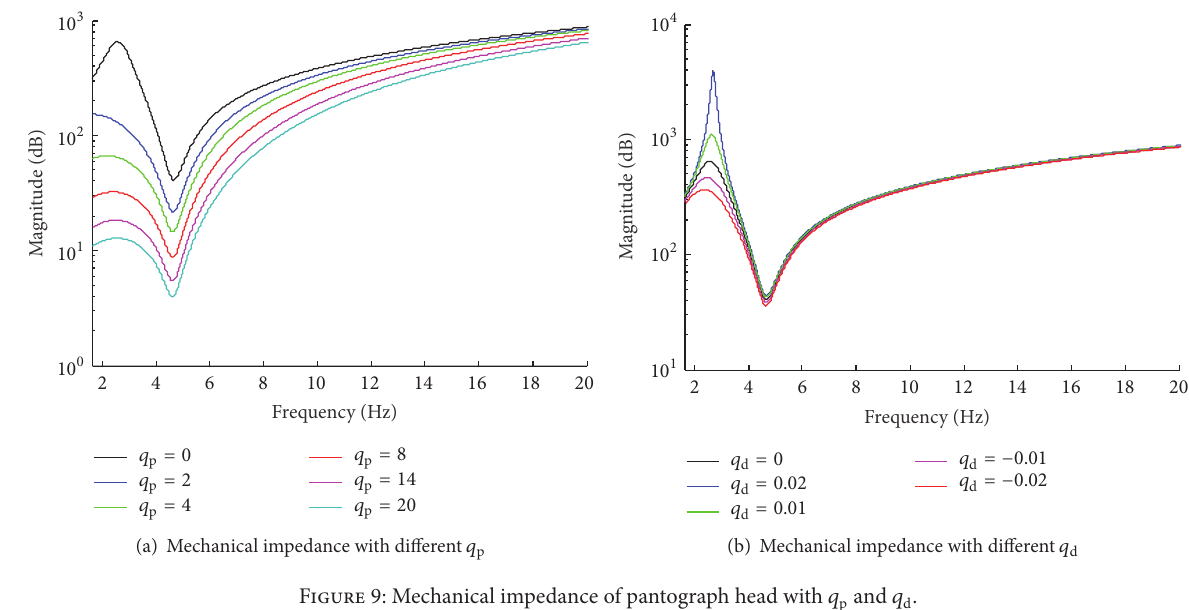
Figure 9: Mechanical impedance of pantograph head with 𝑞 p and 𝑞 d .